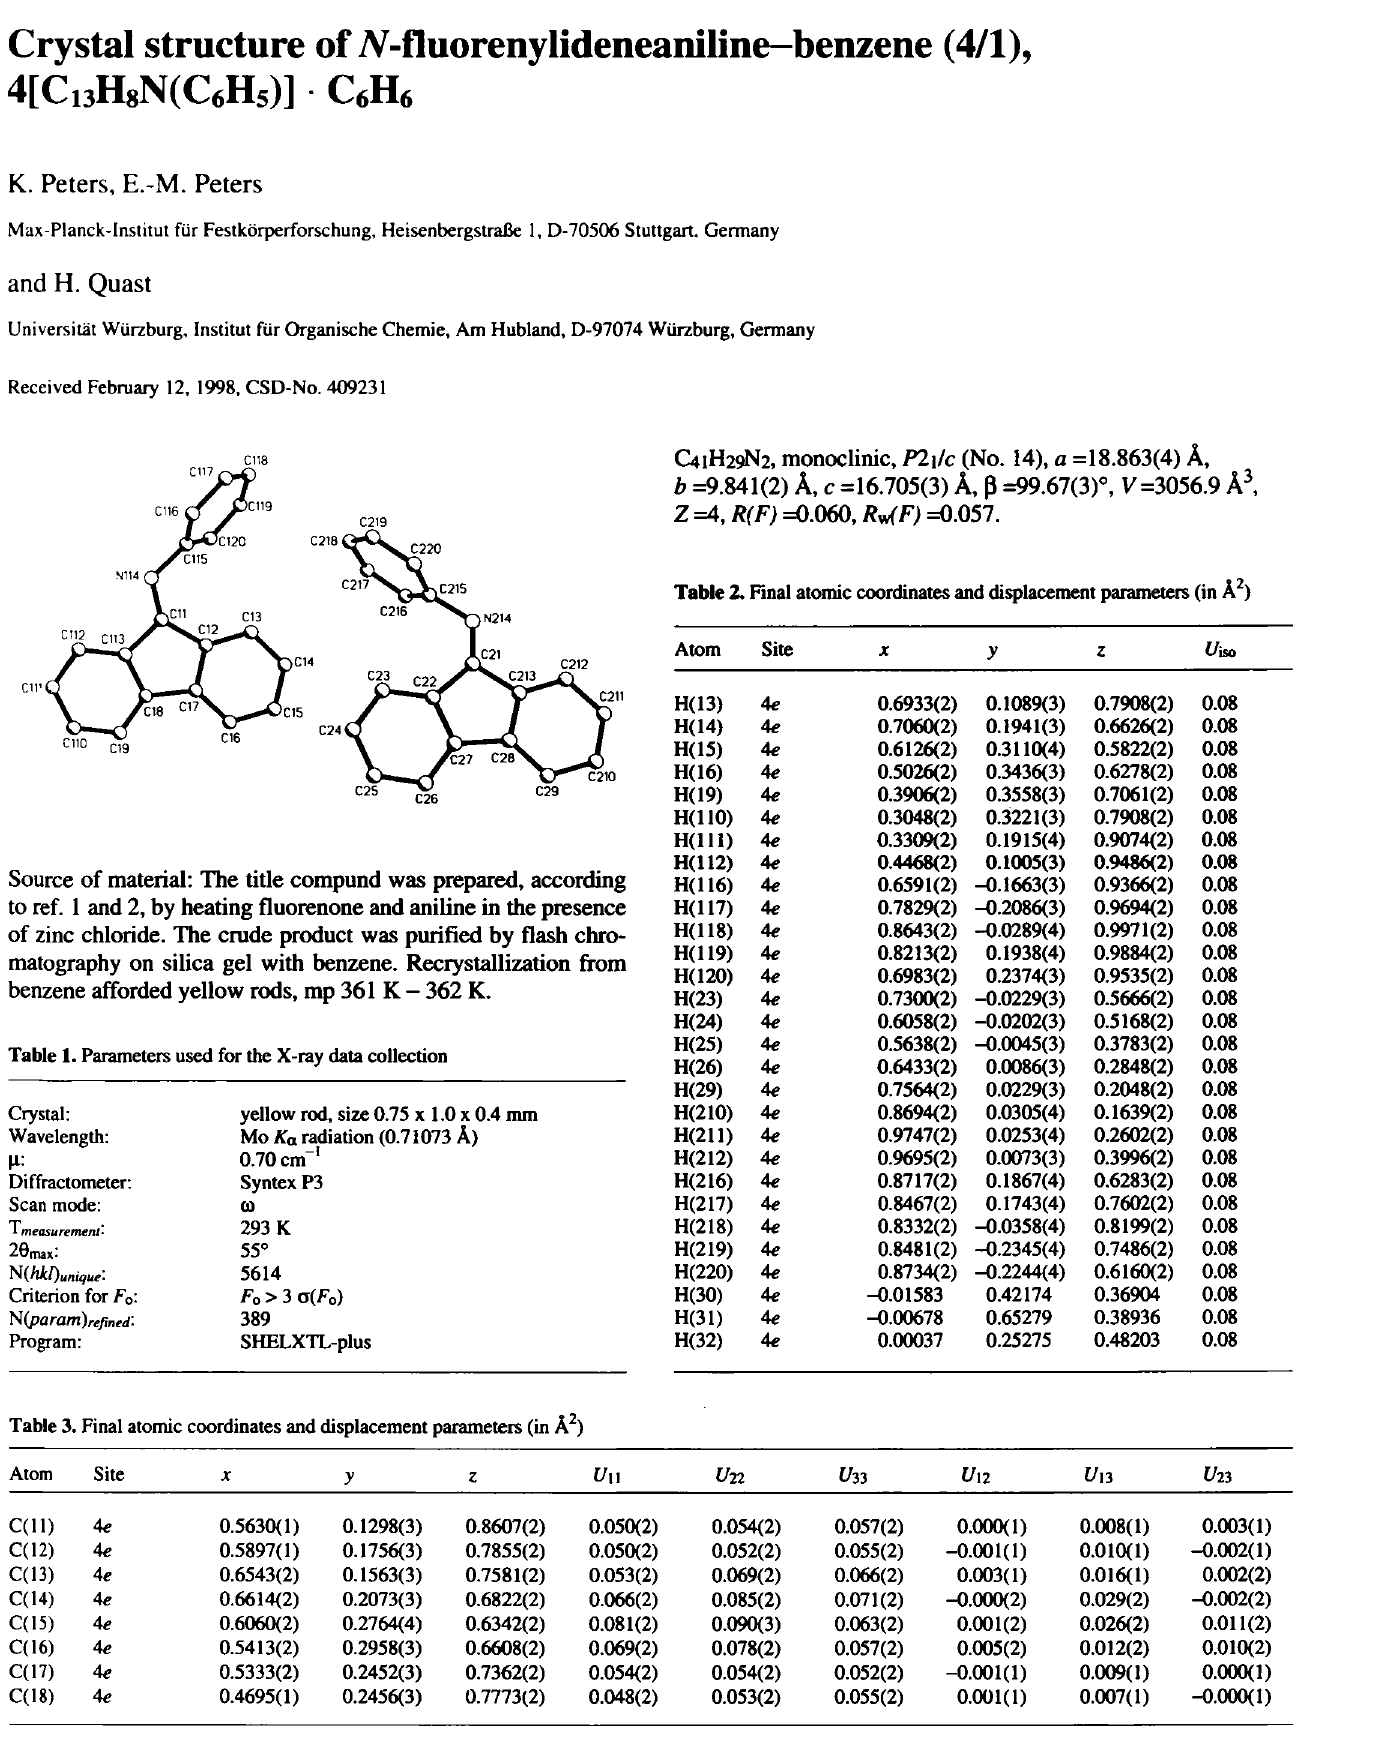
Table 2. Final atomic coordinates and displacement parameters (in Â^)